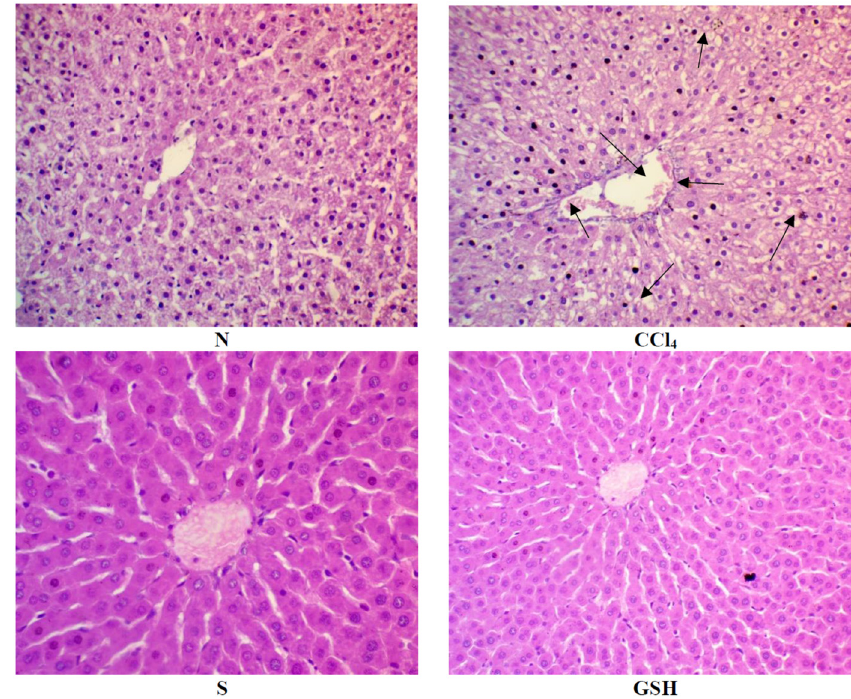
Figure 5: Histopathology of rats ’ liver ( H&E stain ) . N = normal rats; CCl 4 = injured rats; S = silymarin - treated rats; GSH = glutathione - treated rats.